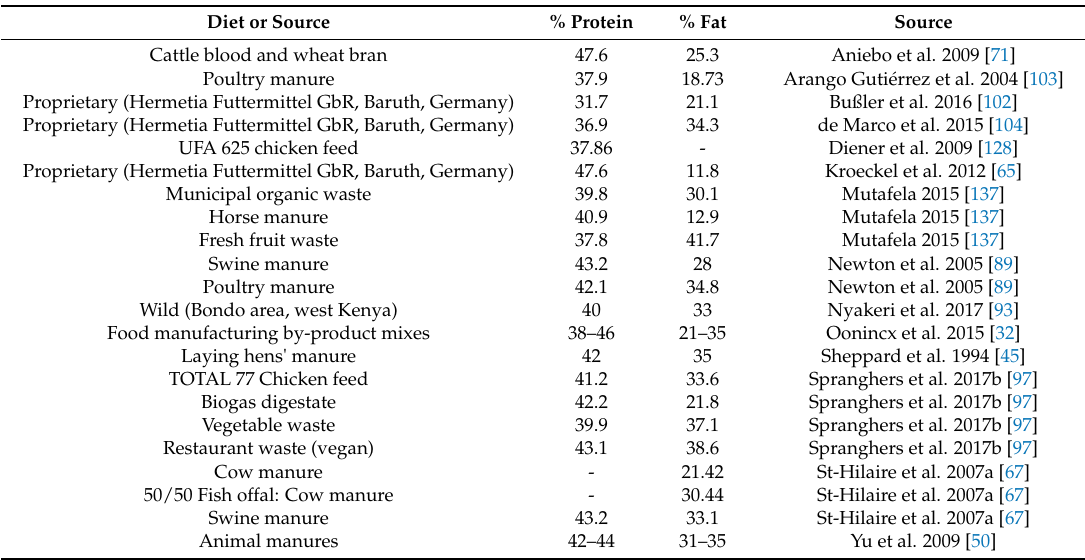
Table 1. Mean % crude protein (not chitin-corrected) and % fat (ether extract) per dry weight of BSFL meal, using mean values from the studies